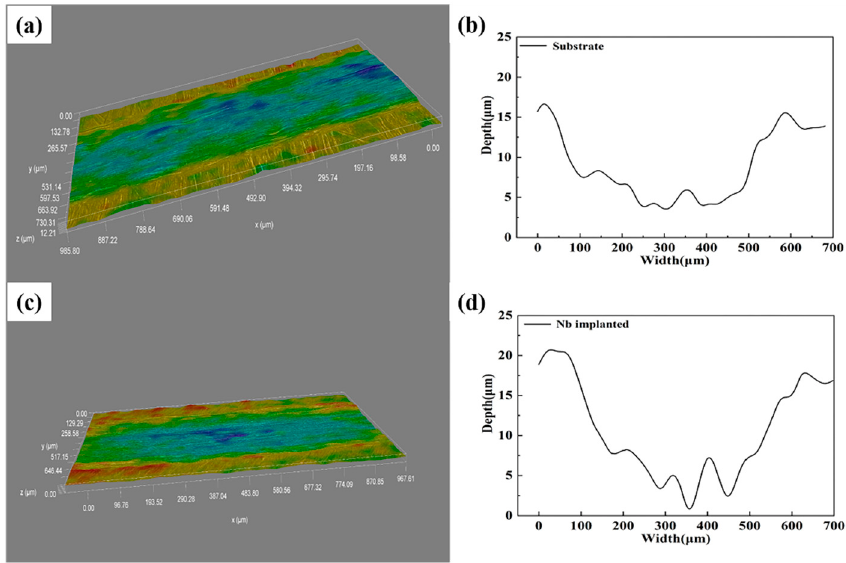
Figure 7. Three-dimensional contours and grinding crack profile of samples: ( a , b ) substrate; ( c , d ) Nb-implanted sample. Table 3. Calculation results of wear scar of samples.